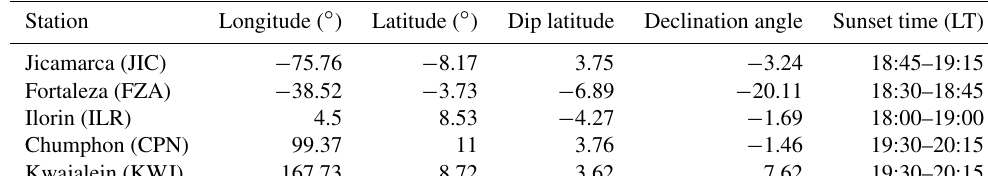
Table 1. Description of the stations’ geographic location and their local sunset time range.